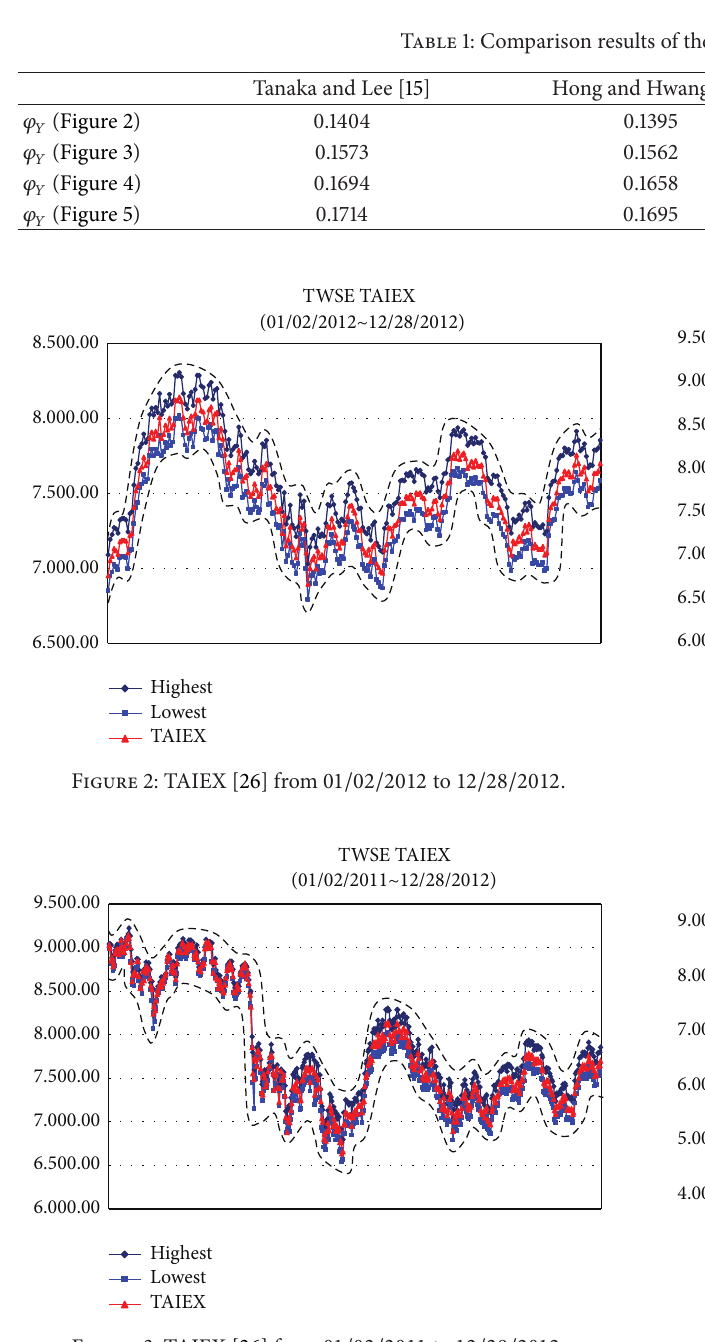
Figure 3: TAIEX [26] from 01/02/2011 to 12/28/2012 .